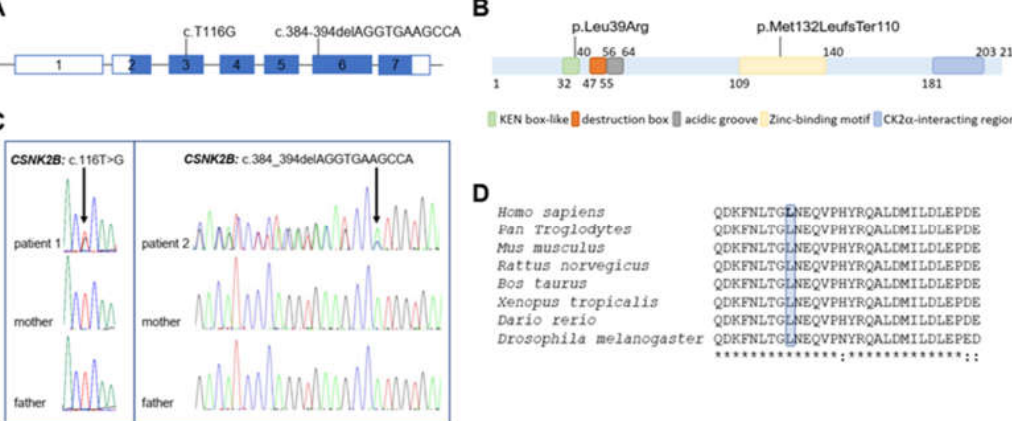
Figure 3. ( A ) Schematic representation of CSNK2B gene. The pathogenic variants identified in this study and their position are shown. Lines and boxes indicate introns and exons, respectively. Exons and introns are numbered with respect to the exon upstream of the first coding exon. The coding regions are indicated by filled boxes, whereas the non-translated sequences are depicted by open boxes. ( B ) Schematic illustration of the CK2beta protein. The position of the mutations is shown. Important regions in the CK2beta protein are indicated by filled boxes: KEN box-like (green) and destruction domain (orange) represent putative degradation motifs; the acidic groove (grey) is involved in the modulation of the catalytic activity; the zinc-finger motif (yellow) mediates the CK2beta dimerization; the region involved in the CK2alpha binding (blue). ( C ) Sanger chromatograms from patients (1–2) and their parents. Mutated nucleotides identified in patient 1 ( CSNK2B , c.116T > G) and in patient 2 ( CSNK2B , c.384_394delAGGTGAAGCCA) are indicated by arrows. ( D ) ClustalW multiple-sequence alignment showing conservation of Leu39 of CK2beta across species which is highlighted by the blue box. Asterisk (*) indicates conserved amino acid and colon (:) for conservative changes.